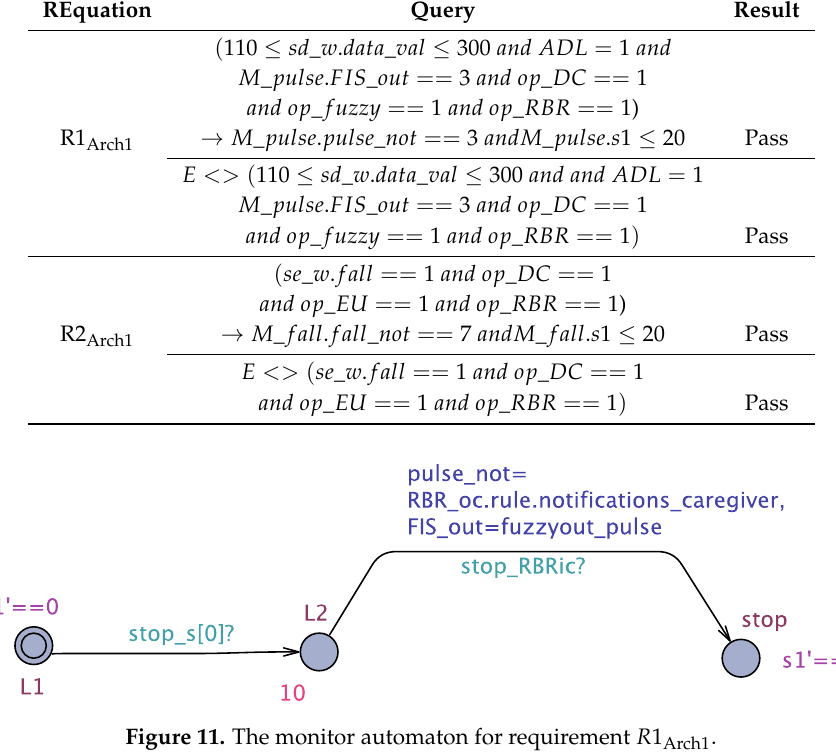
Table 1. UPPAAL analysis results for the minimum configuration architecture.